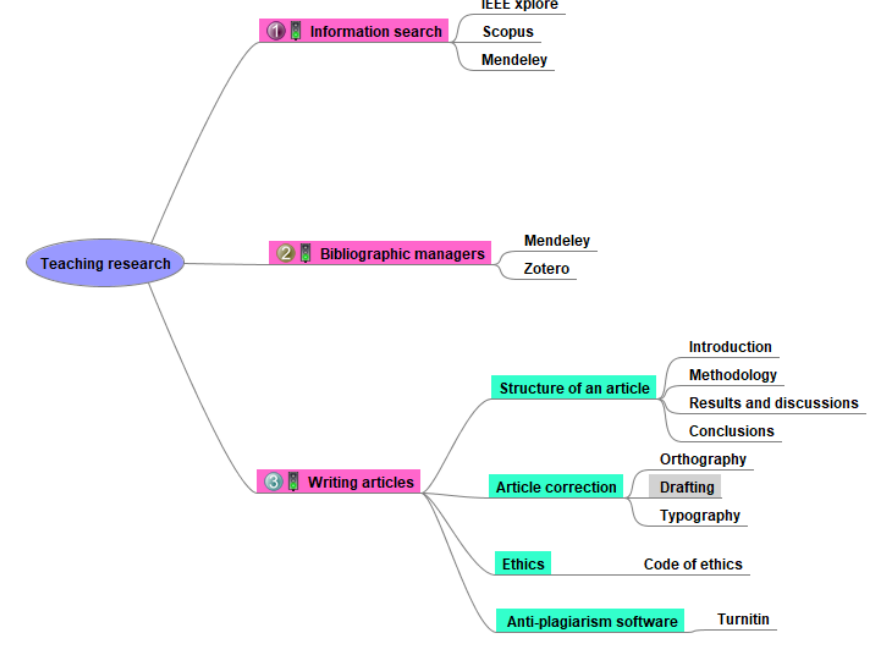
Fig. 5. Teaching and